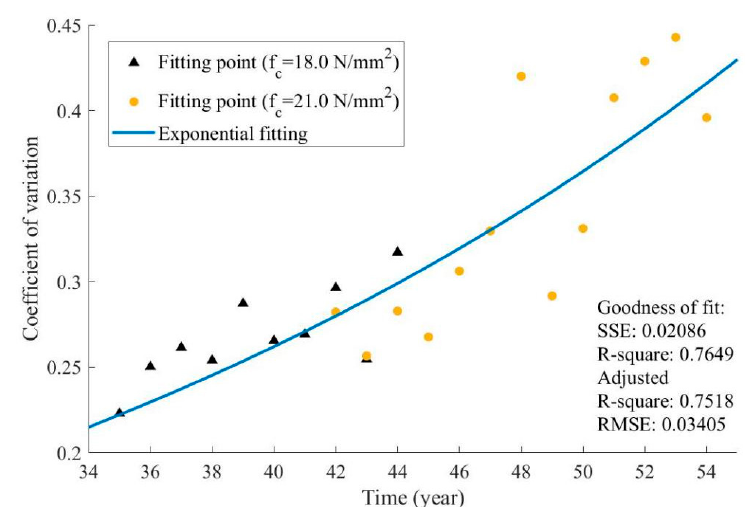
Figure 8. Time-varying coefficient of variation.